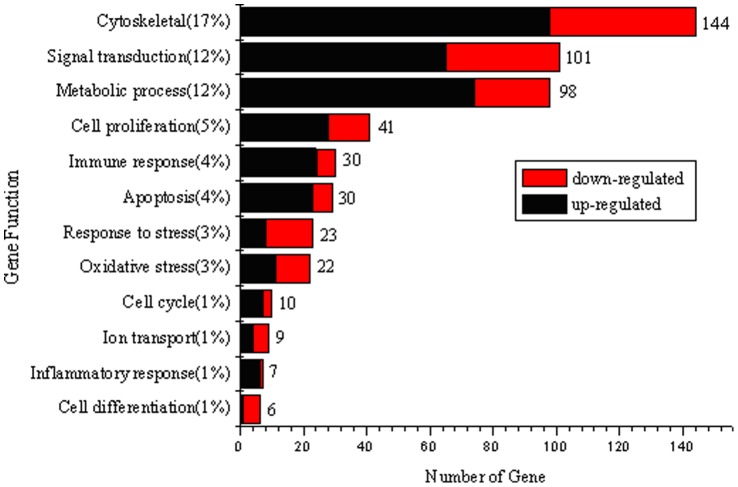
Functional categorization of 521 genes.Genes were functionally classied based on the ontology-driven clustering approach of PANTHER.